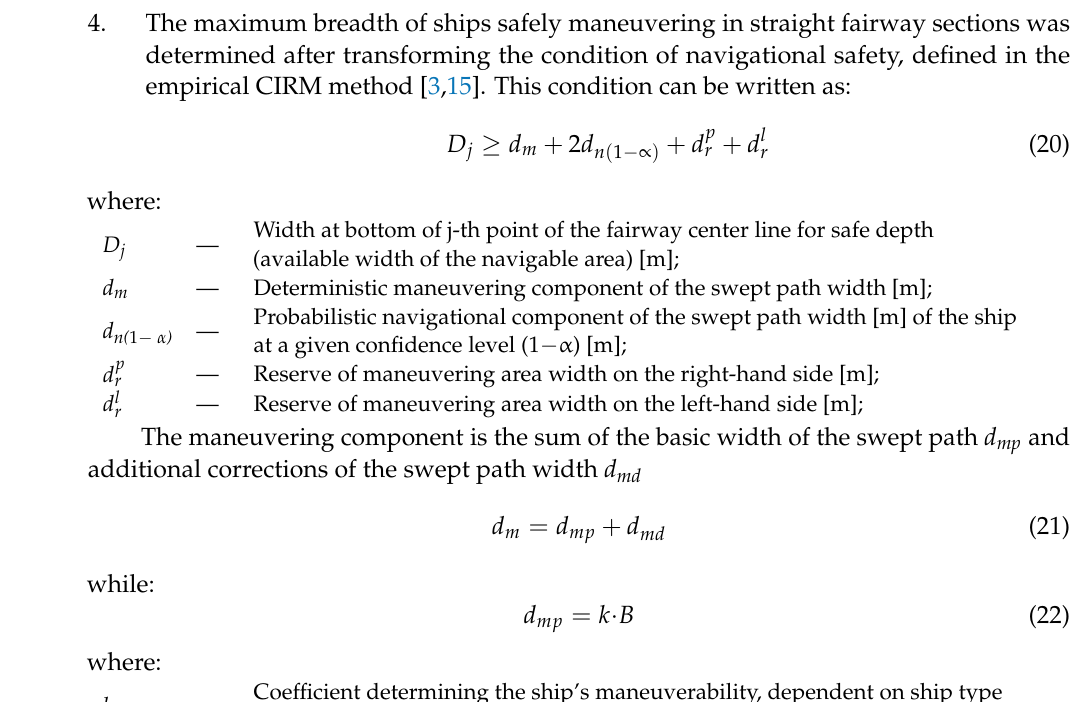
Figure 5. Ś wi ę ta fairway bend. Safe maneuvering area of cruise ship passage Lc = 260 m in least favorable hydrometeorological conditions. Wind S and W, 10 m/s, outgoing current 0.7 knots, UTM coordinates (zone 33U).